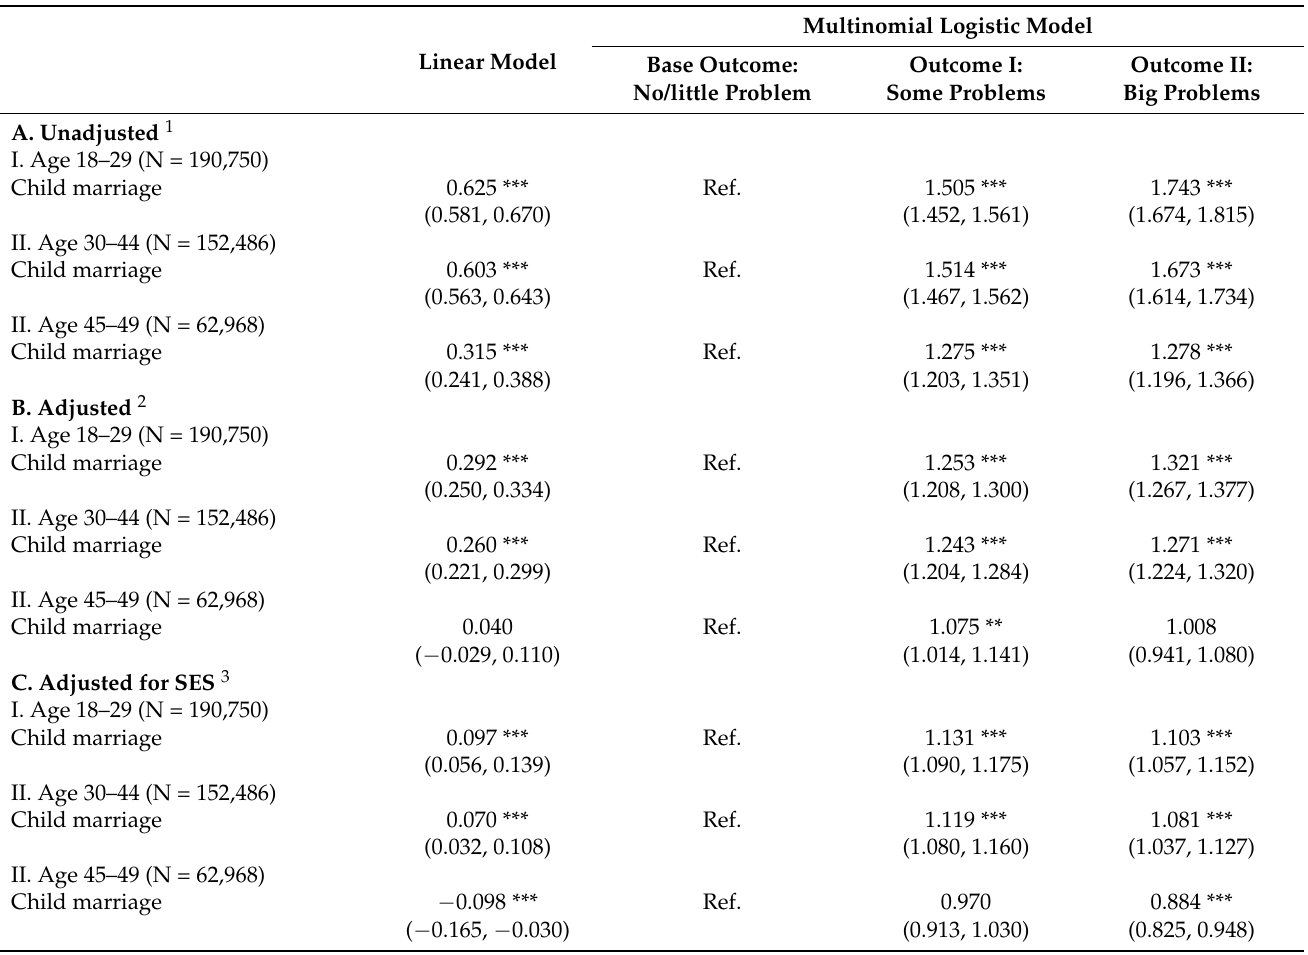
Table 7. Estimates of linear regression and relative risk ratios for facing problems accessing healthcare categorized by score—according to age